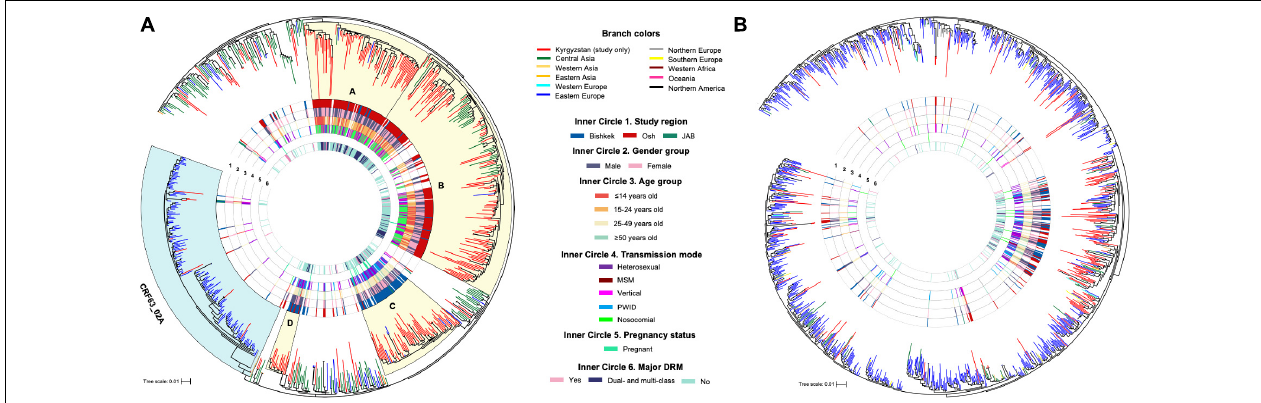
FIGURE 1 | Maximum-likelihood phylogenetic trees of HIV-1 pol sequences of CRF02_AG/CRF63_02A (A) and sub-subtype A6 (B) . Monophyletic clades (A–D) with the branch support ≥ 80 and containing for over 70% of study sequences are shaded in yellow. JAB, Jalal-Abad and Batken provinces; CRF, circulating recombinant form; MSM, men who have sex with men; PWID, persons who inject drugs; DRM, drug resistance